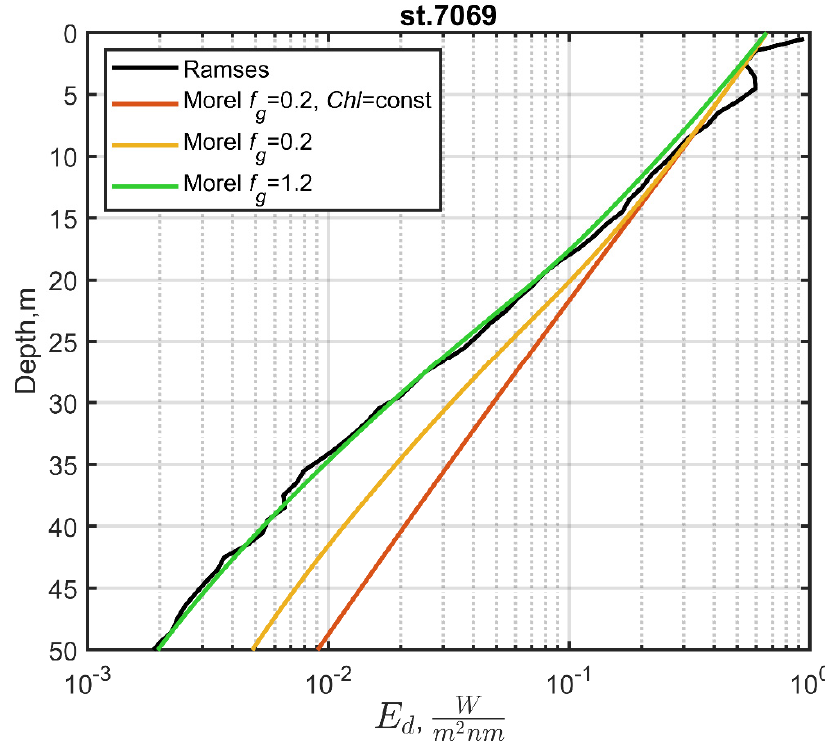
Figure 9. Comparison of downwelling irradiance E d (530, z ) profiles measured with Ramses (black line) and calculated using the ‘case 1 new’ model for f g = 0.2 (red and yellow lines) and f g = 1.2 (green line) at station 7069. The red curve was calculated without taking into account stratification.